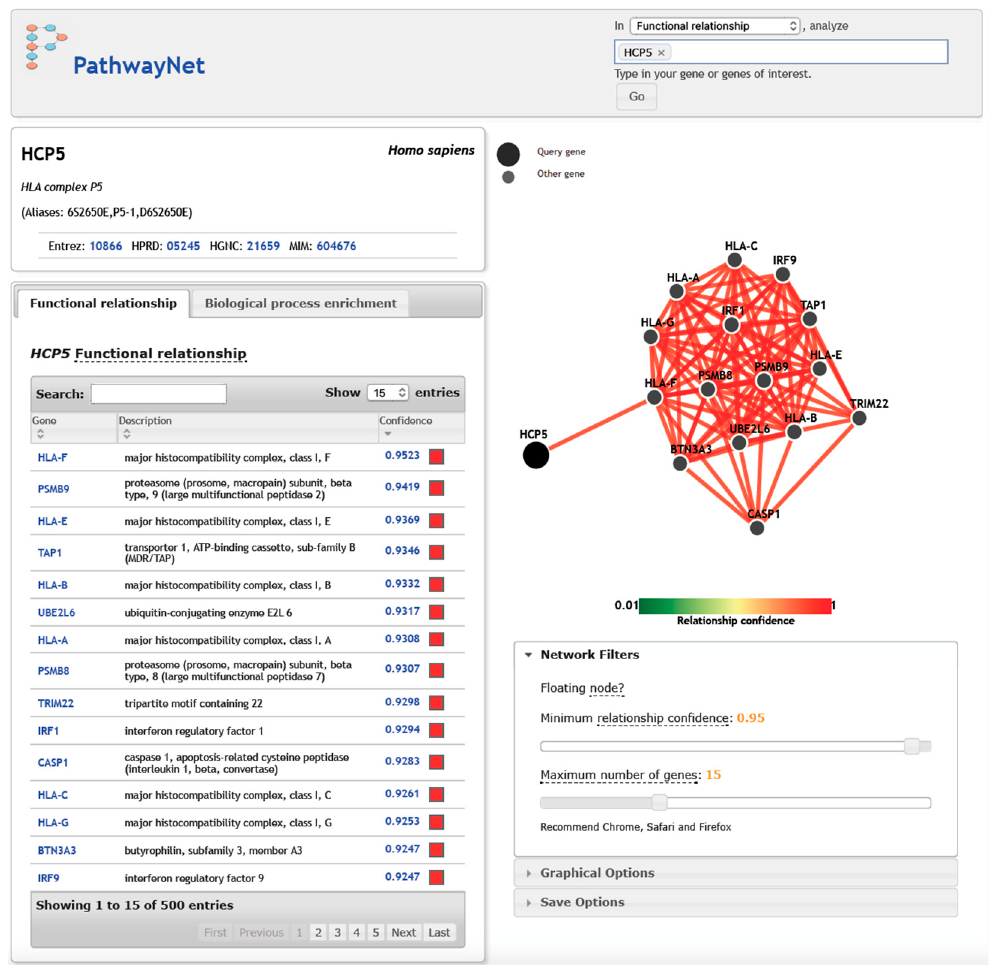
Figure 5. HCP5 functional relationships in PathwayNet (Table S1) [137].